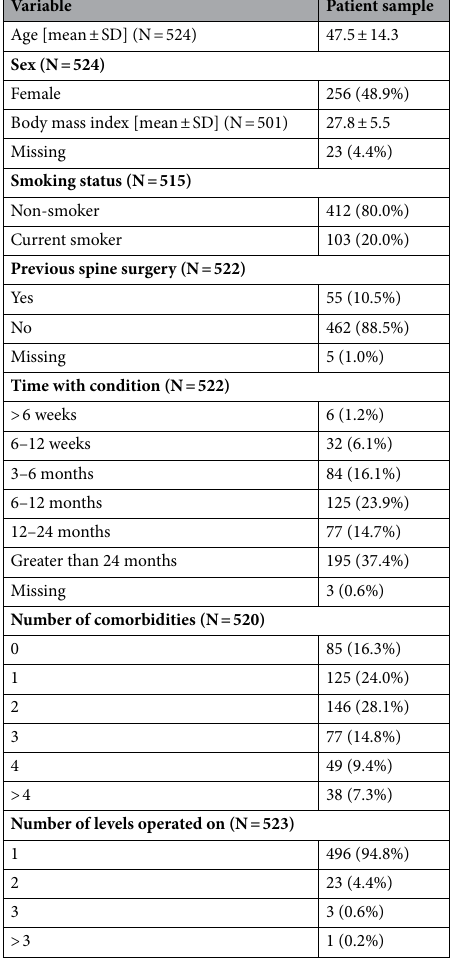
Table 1. Baseline demographics and surgical details of the eligible patient